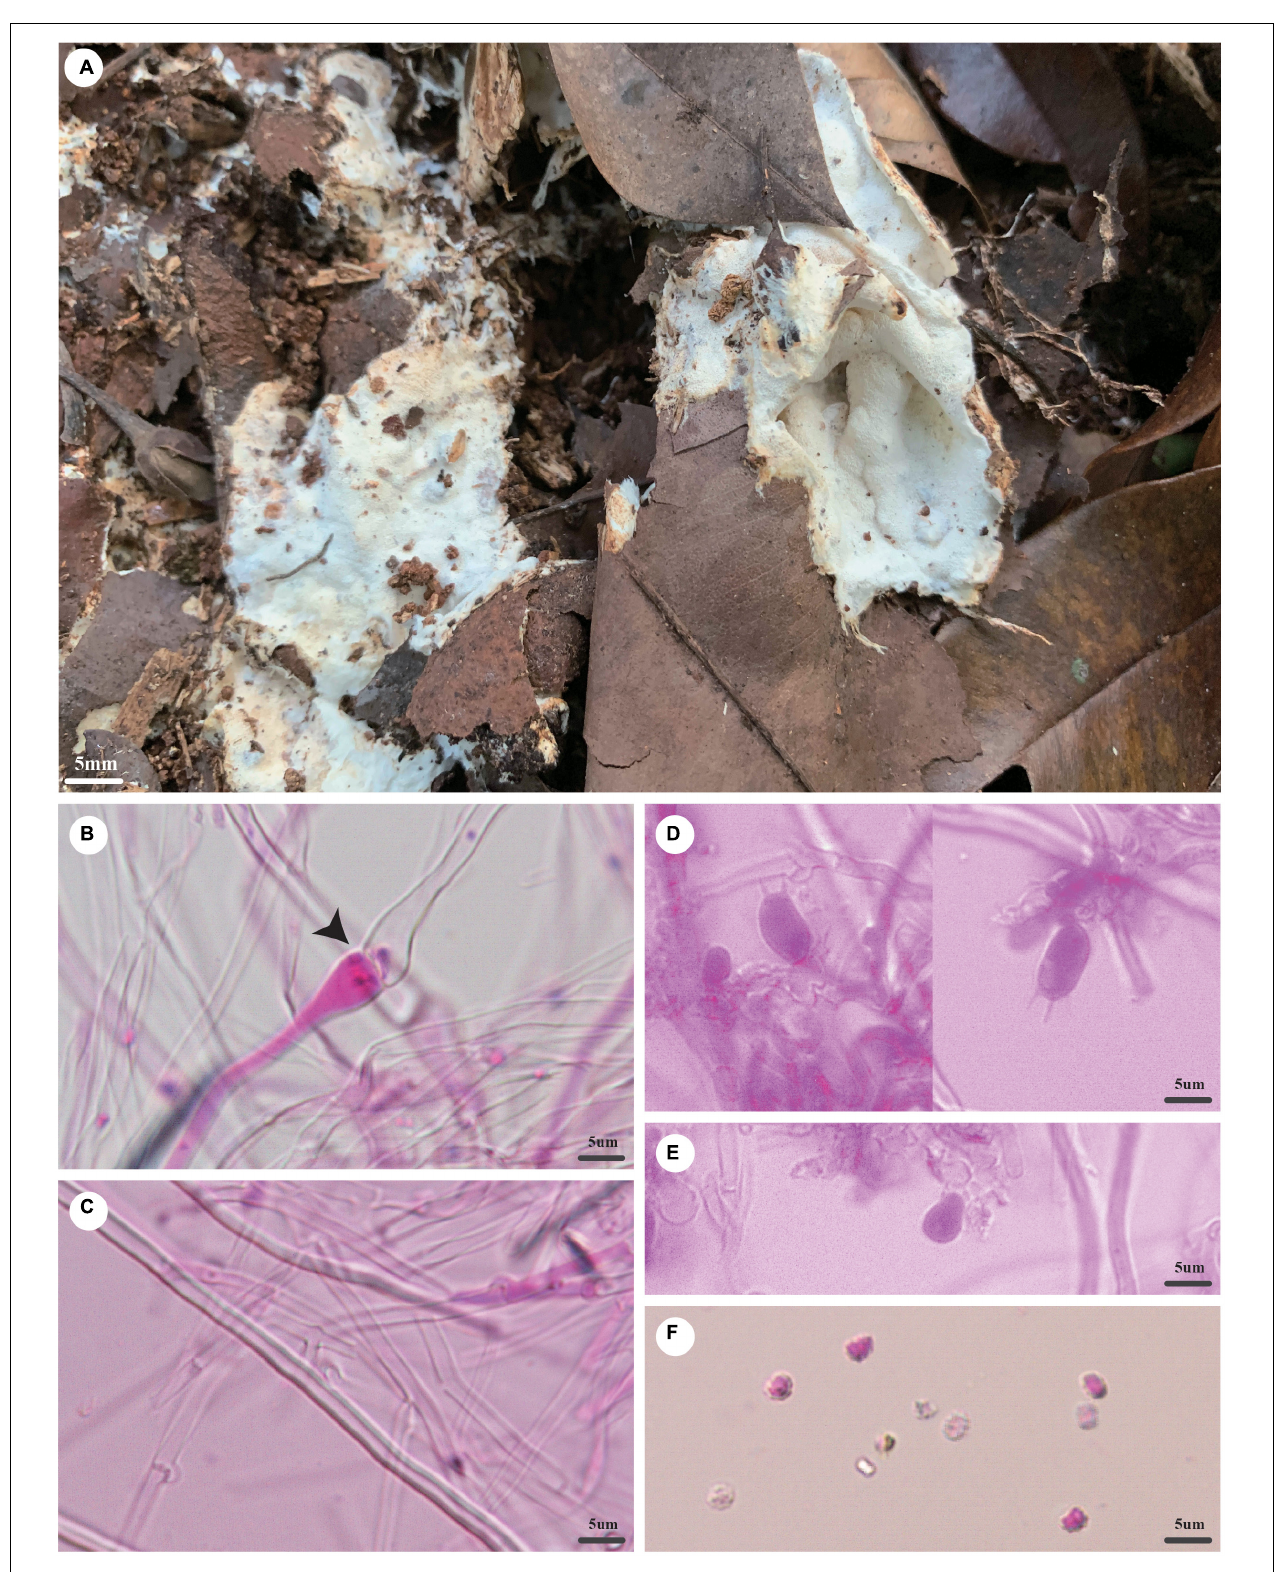
FIGURE 5 | Trechispora dimitiella (holotype, Dai 21931). (A) A basidioma, (B) hyphae with ampullate septa from subiculum (black arrow), (C) hyphae from tubes, (D) basidia, (E) basidioles, and (F) basidiospores. Photo by Ya-Ping Lian and Zhan-Bo Liu.